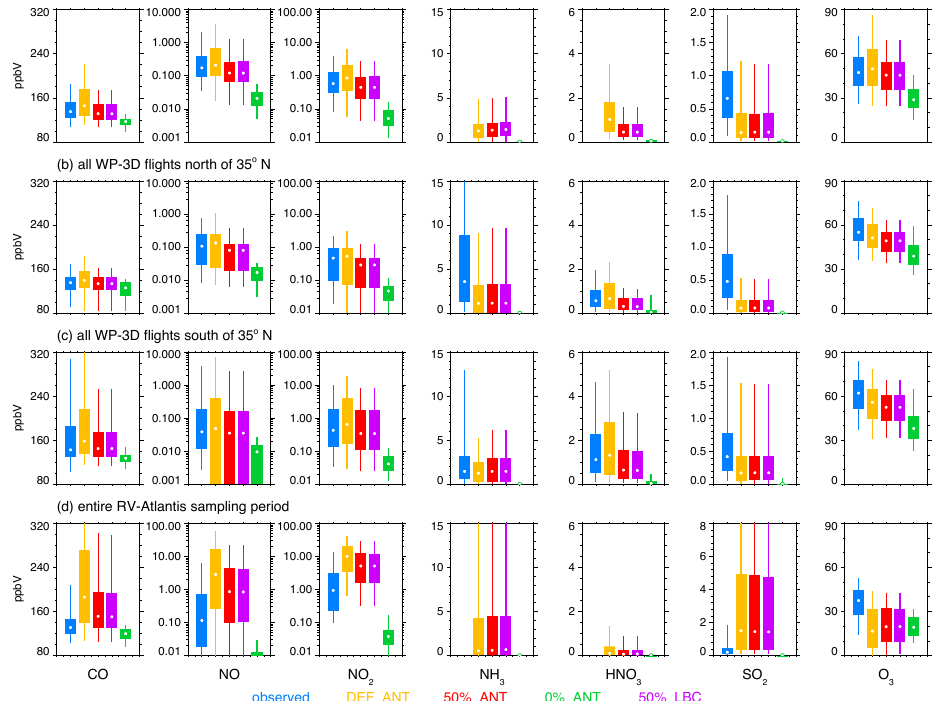
Figure 6. Percentiles for carbon dioxide (CO), nitrogen oxide (NO), nitrogen dioxide (NO 2 ) , ammonia (NH 3 ) , nitric acid (HNO 3 ) , sulfur dioxide (SO 2 ) , and ozone (O 3 ) for all (a) G-1 flights, (b) WP-3D flights north of 35 ◦ N, (c) WP-3D flight flights south of 35 ◦ N, and (d) the entire RV-Atlantis sampling period. Vertical lines denote 5th and 95th percentiles, boxes denote 25th and 75th percentiles, and the white dots denote the 50th percentiles. Note that NH 3 was not measured on the G-1 or the RV-Atlantis, but the model results are included for